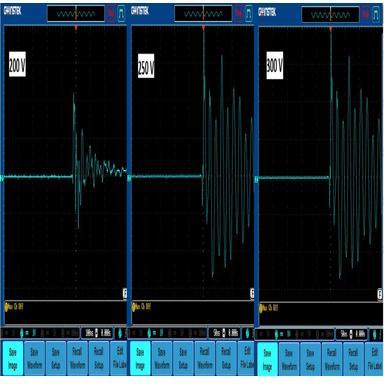
Current probe output.